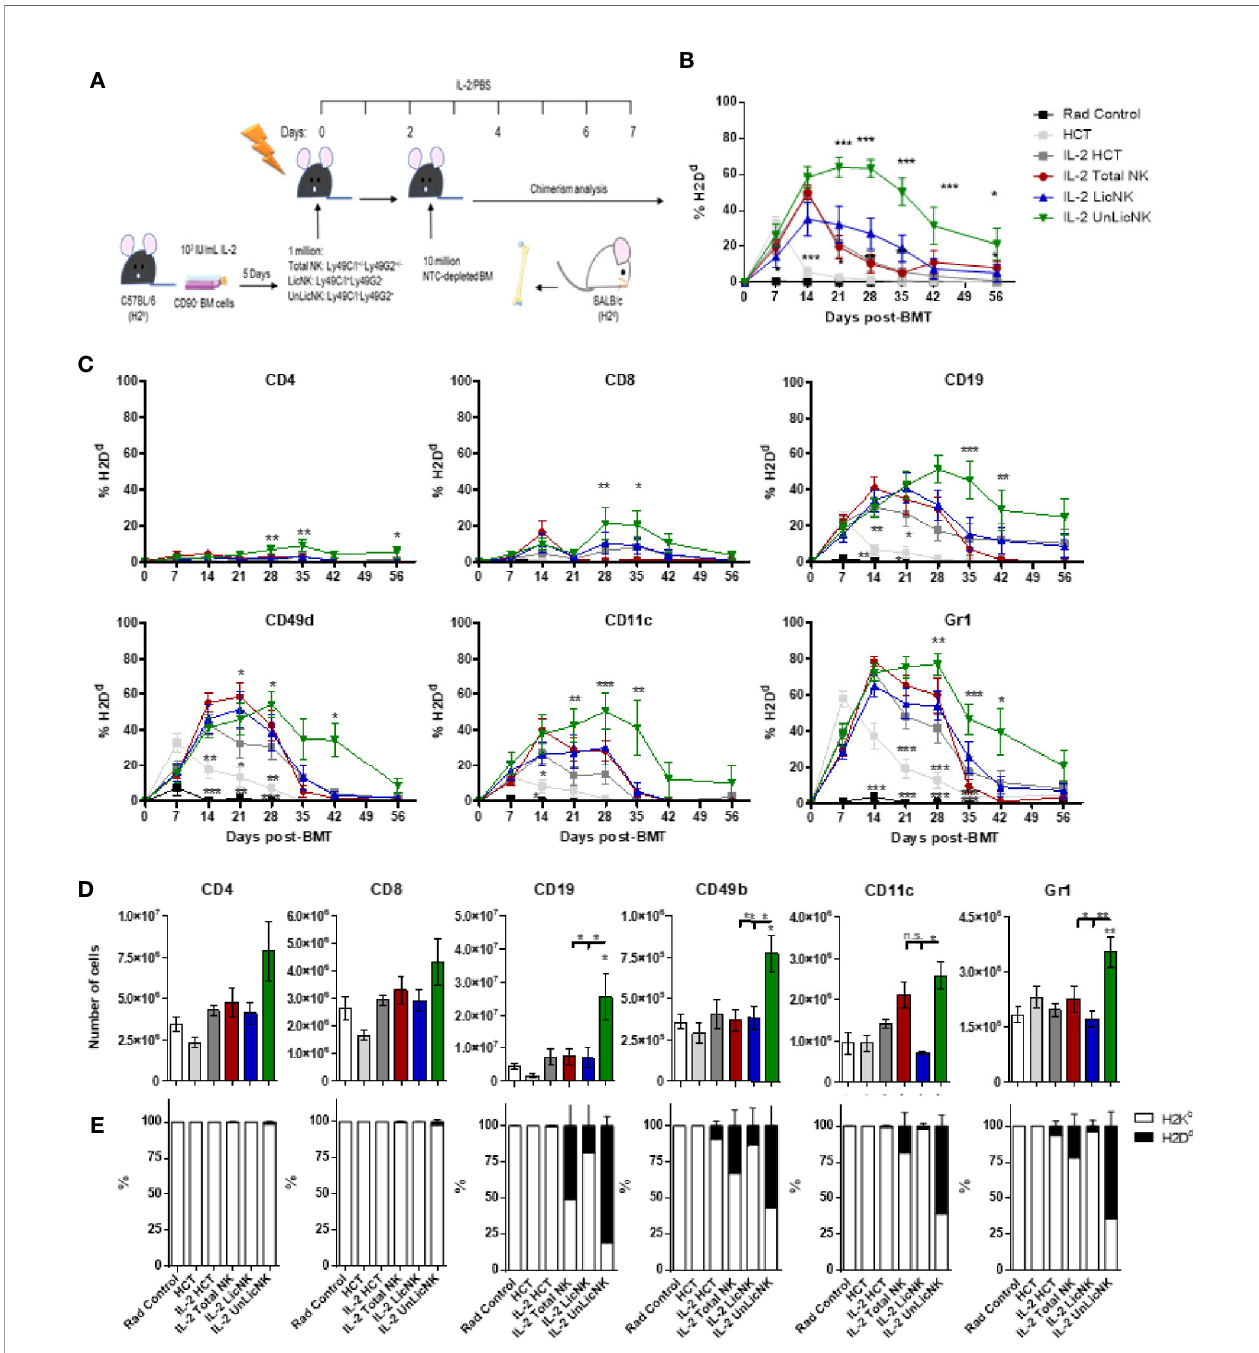
FIGURE 1 | Infusion of host type activated UnLicNK cells improves donor cell engraftment after NMAC allogeneic HCT. Sublethally irradiated C57BL/6 mice received a million ex vivo IL-2 expanded total NK cells (Ly49C/I +/- Ly49G2 +/- ), LicNK cells (Ly49C/I + Ly49G2 - ), UnLicNK (Ly49C/I - Ly49G2 + ) cells or PBS followed by 10 million NTCD-BMC 2 days later. Mice were treated with IL-2 (5x10 4 IU/ml) or PBS for seven consecutive days following NK cell transfer. (A) Schematic representation of NMA HCT regimen. (B) Percentage of total H2D d+ cells at each time point after NMAC HCT is shown for gated CD4 (CD45.2 + TCR b + CD4 + ), CD8 (CD45.2 + TCR b + CD8 + ), CD19 (CD45.2 + TCR b - CD19 + ), CD49b (CD45.2 + TCR b - CD49b + ), CD11c (CD45.2 + TCR b - CD19 - CD11c + ), and Gr1 (CD45.2 + TCR b - CD19 - CD11b + Gr1b + ) -positive cells. (C) Percentage of donor H2D d+ cells among CD4 + , CD8 + , CD19 + , CD3 - CD49b + , CD11c + , or Gr1 + cells is shown. (D) Total number of CD4 + , CD8 + , CD19 + , CD3 - CD49b + , CD11c + , and Gr1 + cells is shown at day 28 post-HCT in the spleen. (E) Proportion of host (H2K b ) and donor (H2D d ) is shown for each cell type in the spleen at day 28 post-HCT. Data is representative of at least two independent experiments with n=3 – 5 per group (mean ± SEM). One-way ANOVA or Two-Way ANOVA was used to assess signi fi cance. Signi fi cant differences are displayed for comparisons with the IL-2 HCT control group (*p<0.05, **p<0.01,